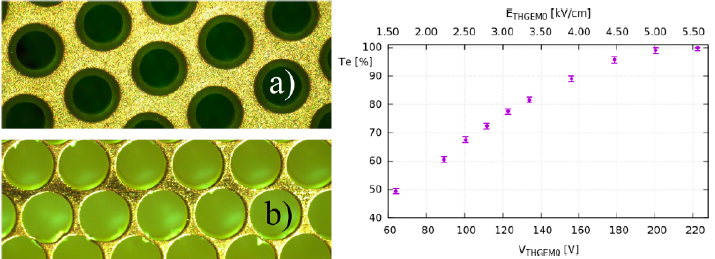
Figure 21. Left: microscope images of two THGEM electrodes used as interface grids in two-phase Ar detectors in [9,12]: with 28% (a) and 75% (b) optical transparency (from [79], with permission from Elsevier). Right: calculated electron transmission through 28% THGEM acting as an interface grid immersed in liquid Ar as a function of the voltage across THGEM (bottom axis) and nominal electric field in THGEM (top axis) (from [79], with permission from Elsevier). The electric fields below and above the THGEM were 0.56 and 4.3 kV / cm